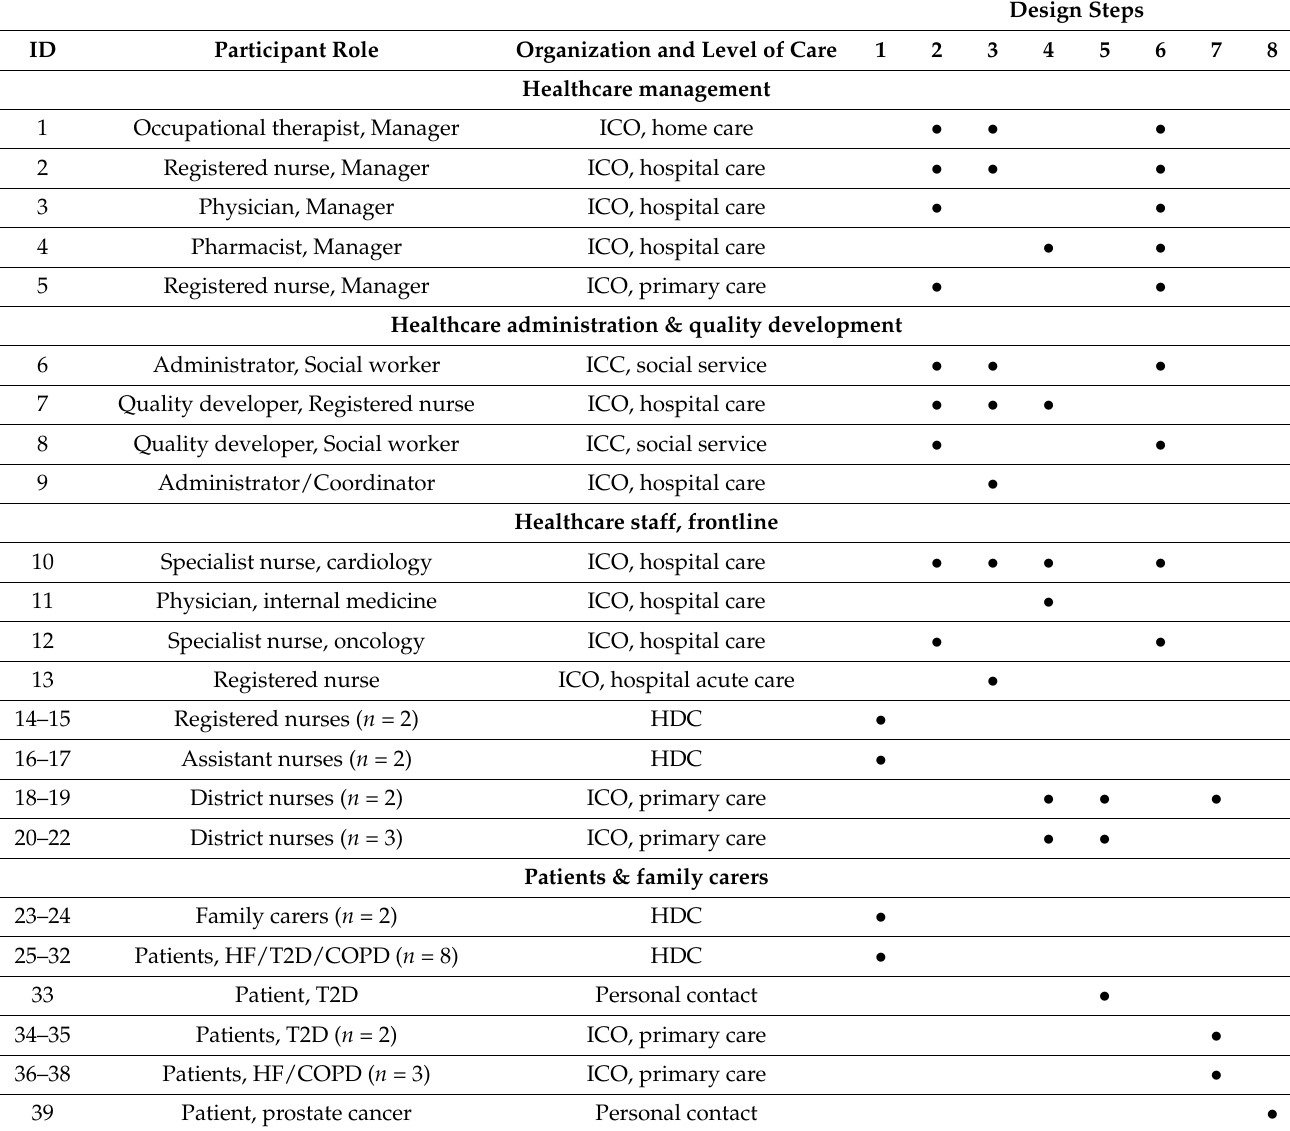
Table 1. Overview of participant involvement in all design phases, steps